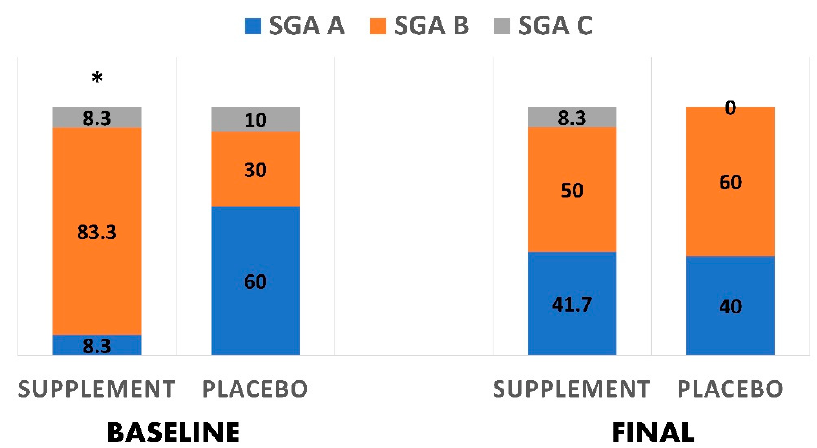
Figure 4. Changes in the nutritional status based on the subjective global assessment tool before and after interventions in both groups. * indicates a significant difference ( p < 0.05).